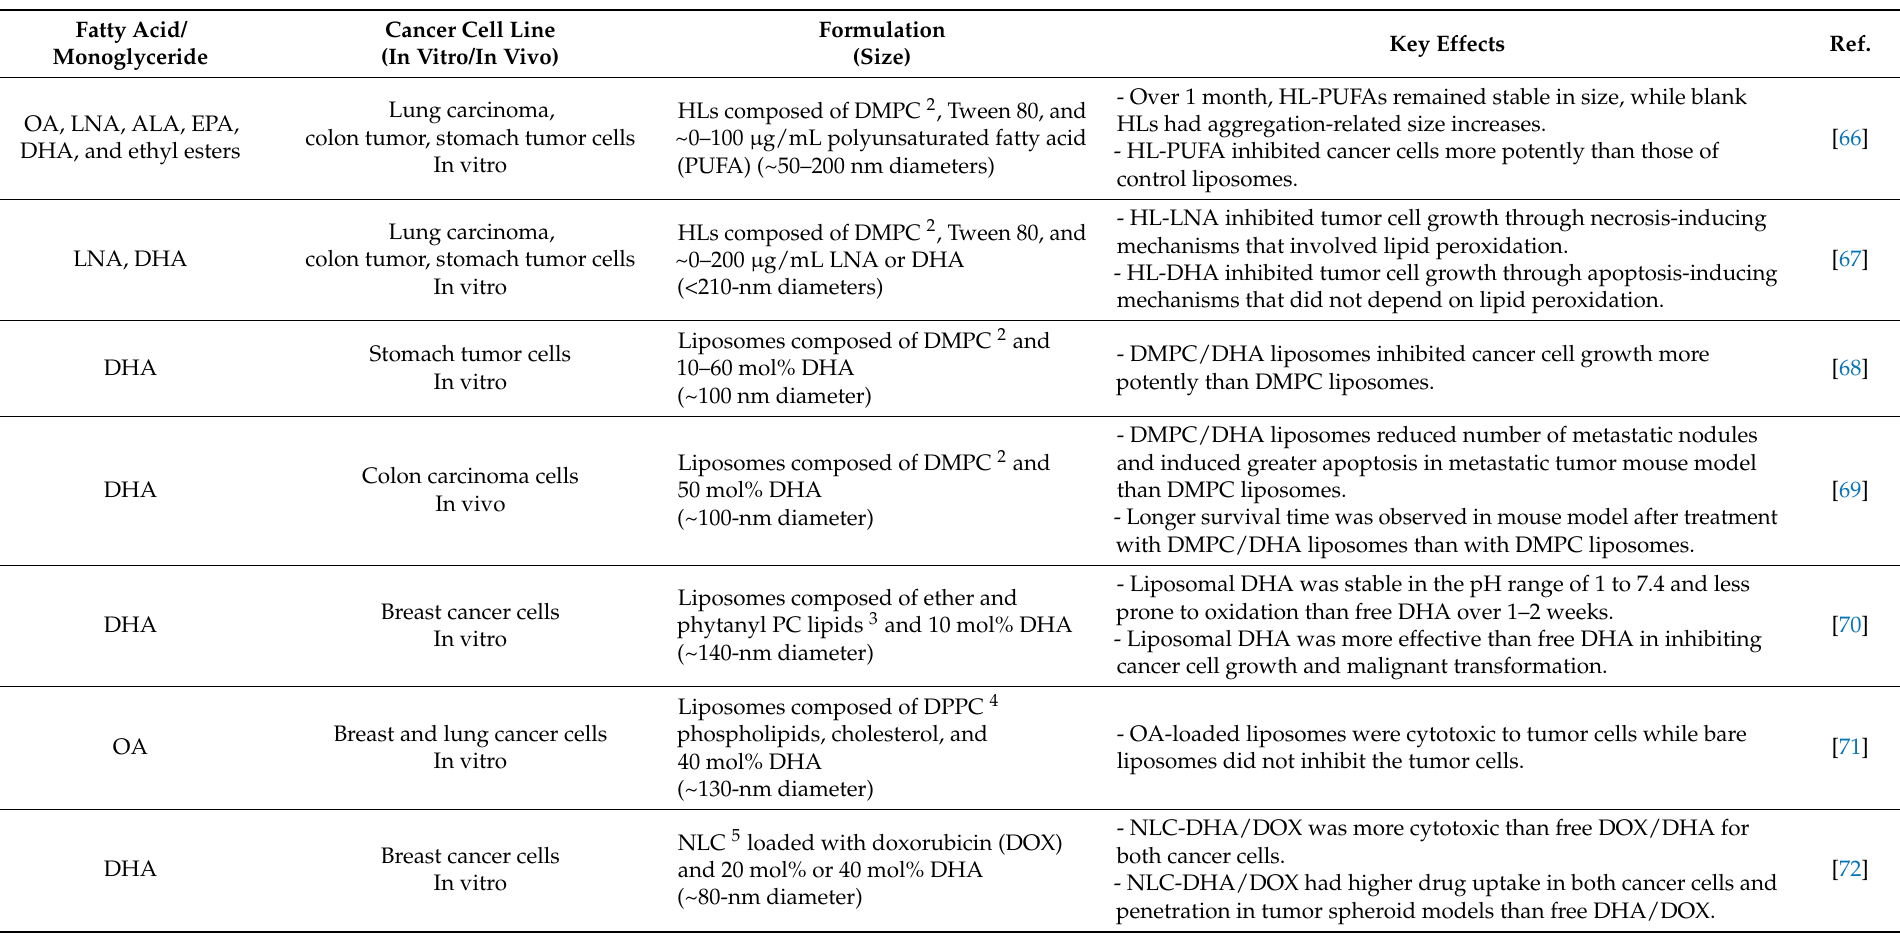
Table 2. Summary of anticancer application examples utilizing lipid nanoparticles that incorporate biologically active fatty acids and monoglycerides 1